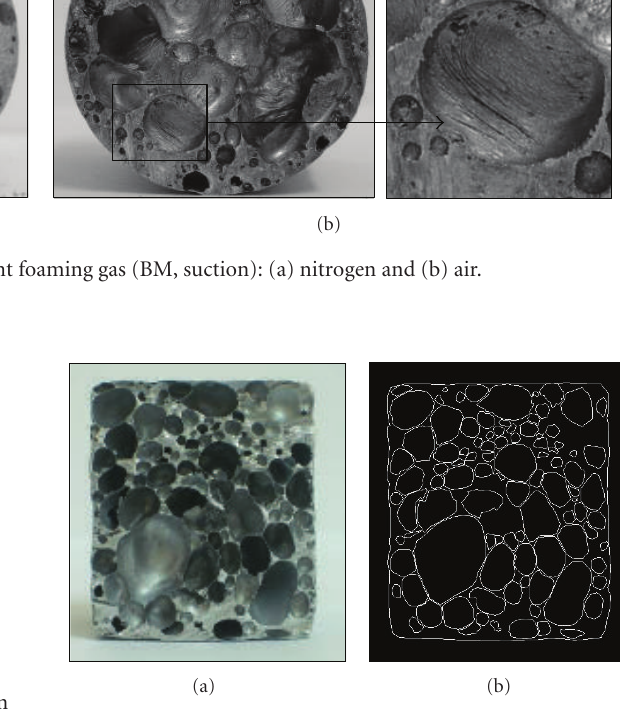
Figure 16: Geometrical structure of foam ( l = 32mm).